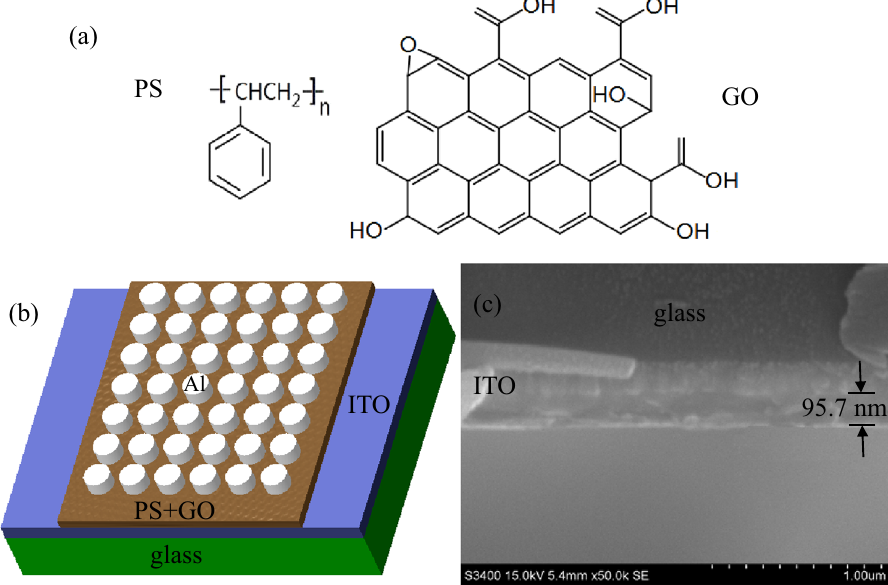
Figure 1. ( a ) Molecular structures of PS and GO. ( b ) The schematic diagram of the structure for the ITO/ PS + GO/Al devices. ( c ) The SEM image of GO embedded in a PS